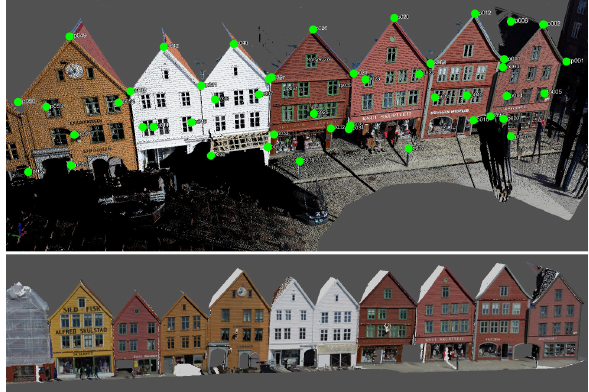
Figure 5: Rendering of the Bryggen dataset as coloured point set (top) and textured surface model (bottom), stretching along 40 m laterally. The green markers (top) highlight 3D control points for manual registration procedures.